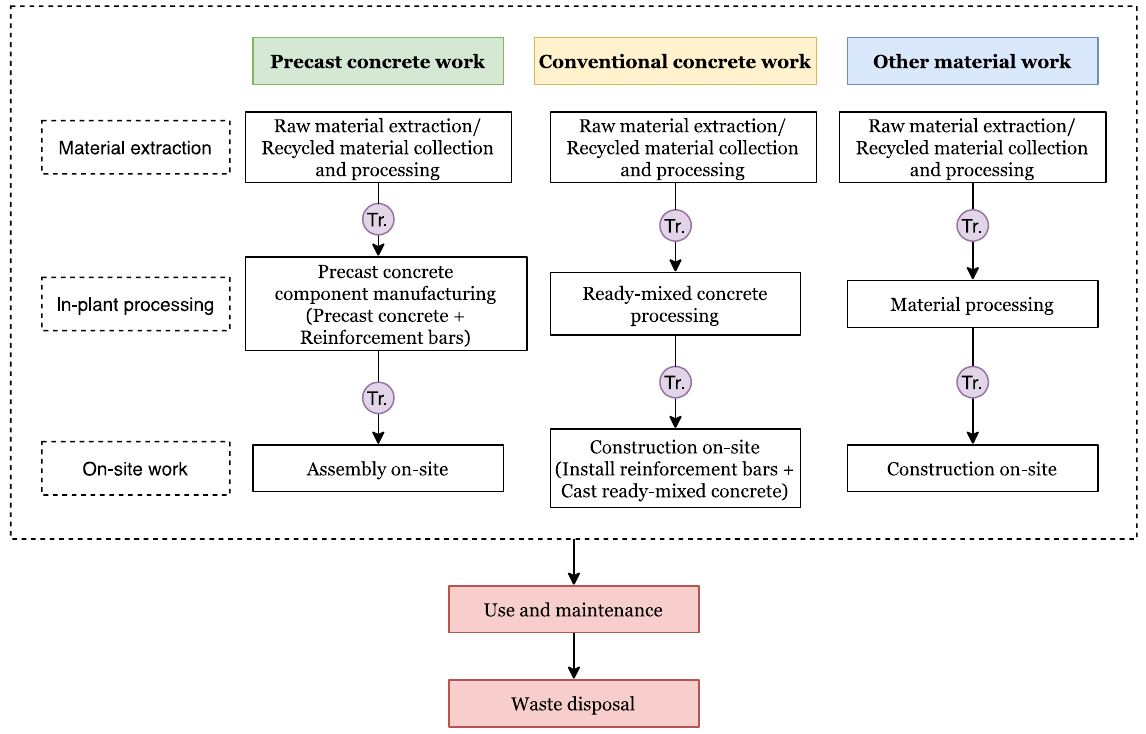
Figure 1. The simplified diagram of the construction activities of the reference building. Figure 1 indicates that this LCA is “cradle-to-gate”, including four lifecycle stages: